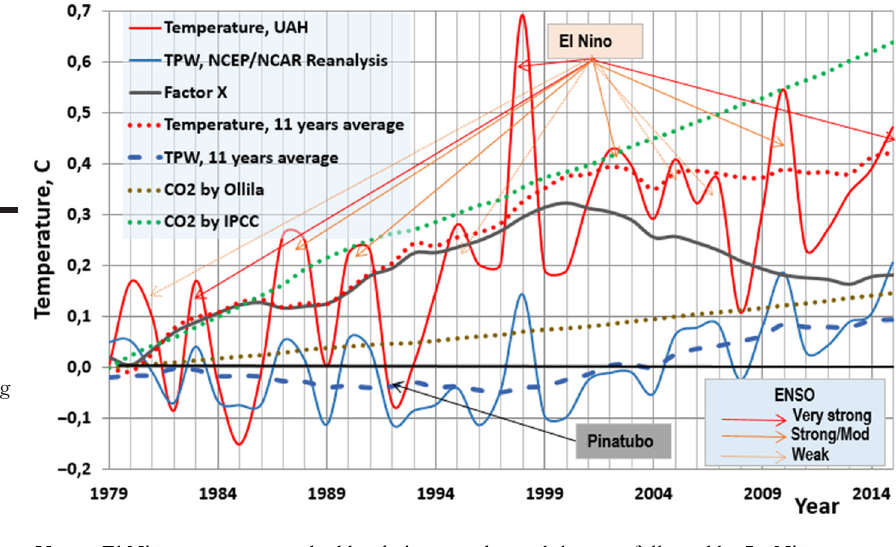
Figure 7. The temperature trend from